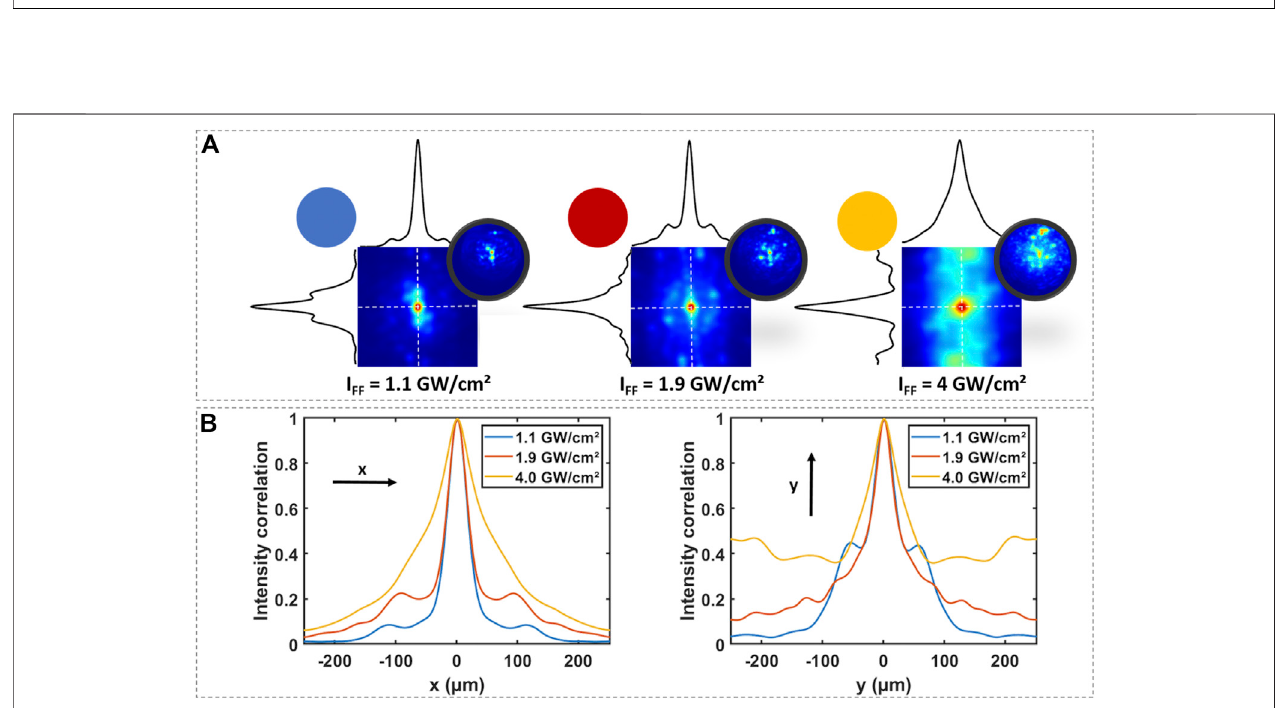
FIGURE4|(A) — intensitycorrelations C I ofthenear- fi eldimagesoftheSHbeam attheoutputoftheKTPcrystal, (B) — comparison ofthespatialpro fi leofintensity correlations along the x and y directions, respectively. Data refer to acrystal orientation of θ (cid:1) 90 ° , Φ (cid:1) 23.5 ° + 0.33 ° and input polarization orientation of 47 ° . The circular insets are extracted from the corresponding cases of Figure 2 .